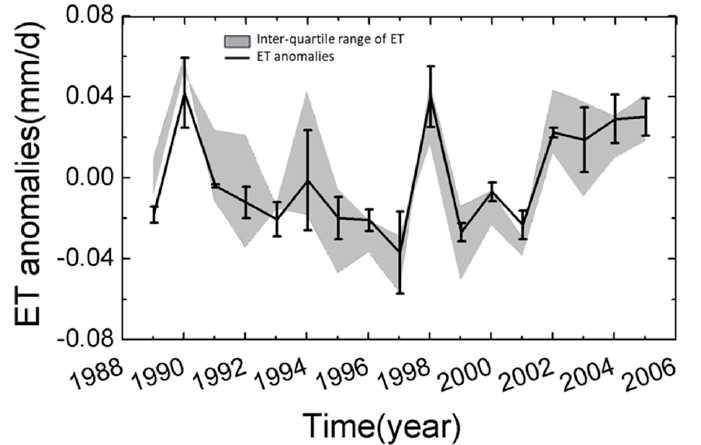
Figure 6. Evolution of national mean ET anomalies from 1989 to 2005 in China. The black lines with error bars represent the annual ET anomalies, and the gray shadow is the quartile range.